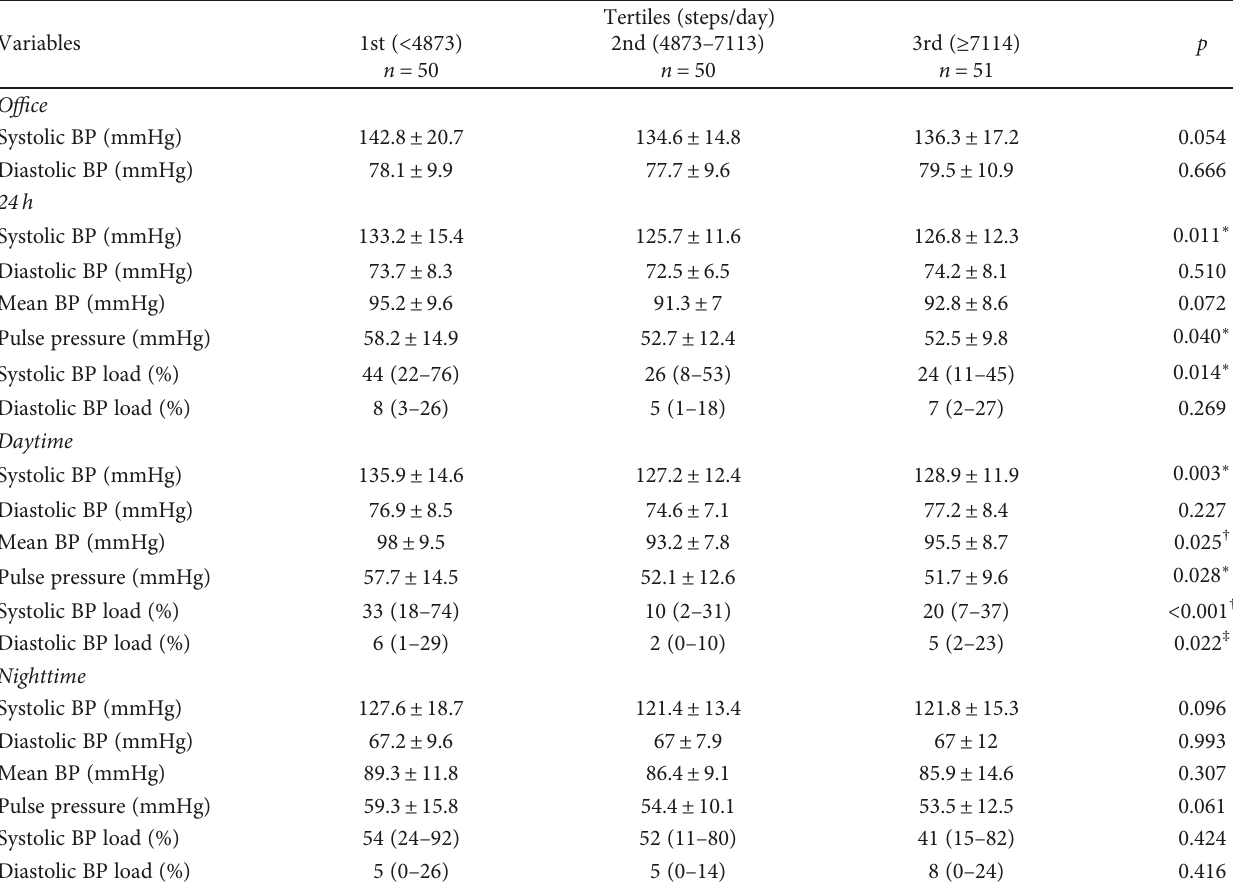
Table 2: Blood pressure pro fi les, strati fi ed by step count tertiles.